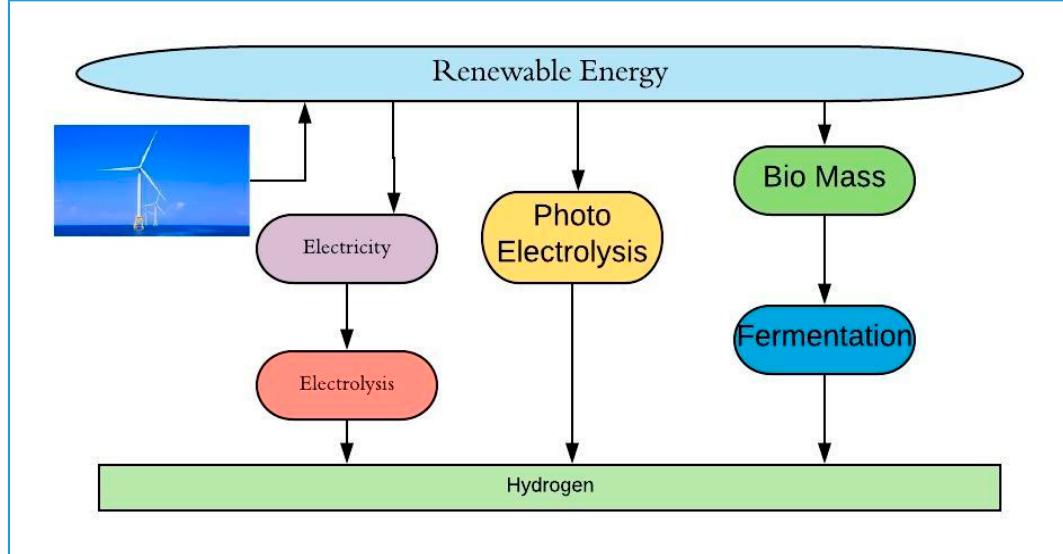
Figure 1. Hydrogen production through different ways.